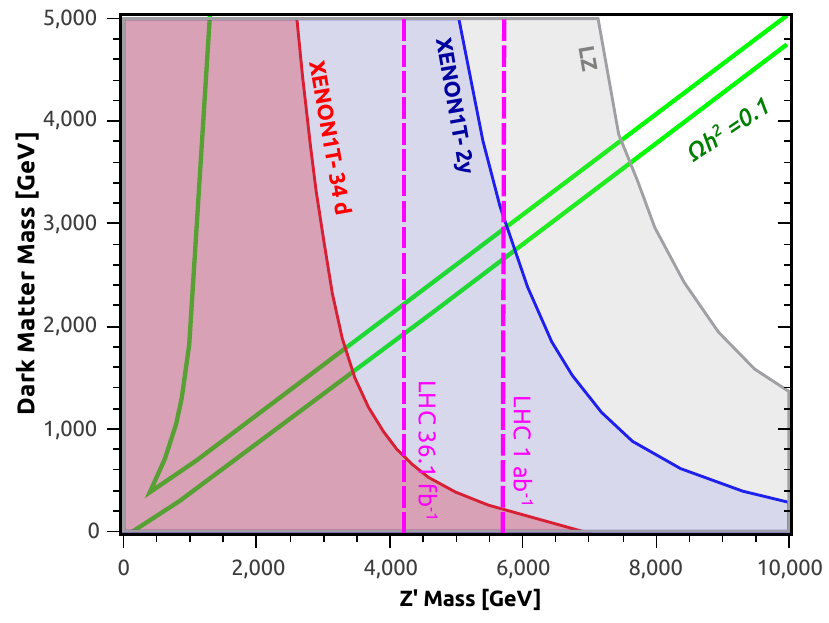
Figure 1 . Summary plot for the fermion dark matter. Relic density curve (green), LHC (pink) and current direct detection limit from XENON1T-34 days (red) [67], projected from XENON1T-2 years (blue) [74] and LZ (gray) [75] are overlaid. See text for